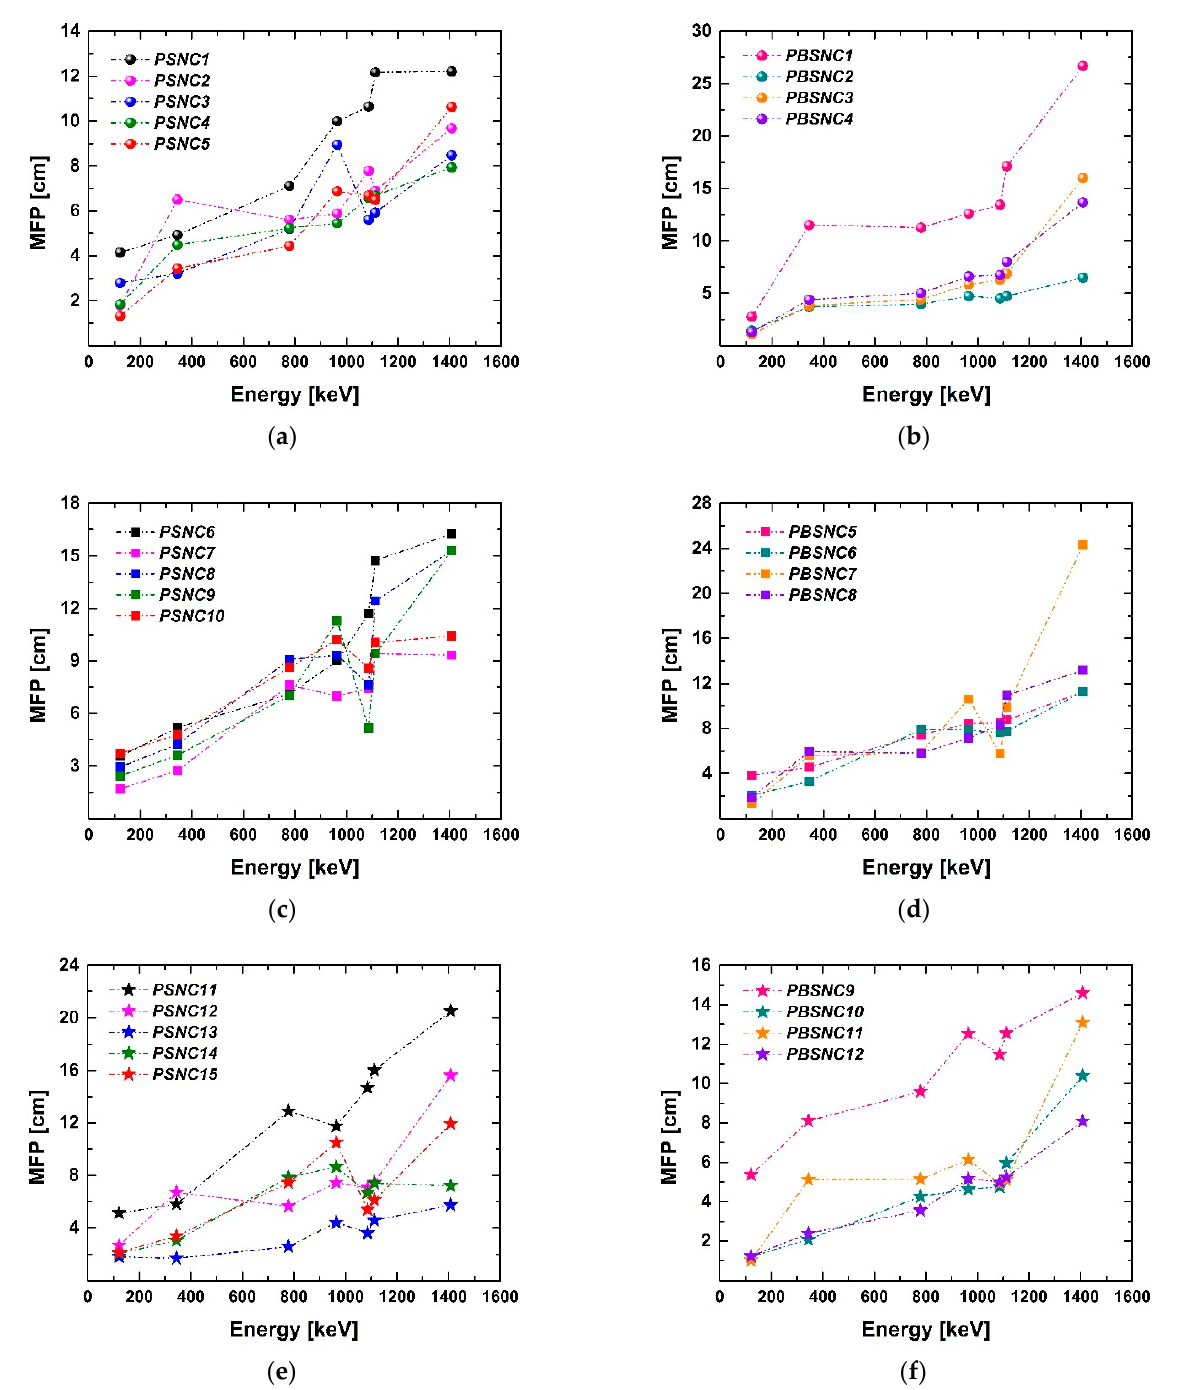
Figure 11. The MFP rates of the PS-b-PEG copolymers blended with the nanostructured SeO 2 and BN particles under a wide range of gamma irradiation energies: PSNC1, PSNC2, PSNC3, PSNC4, and PSNC5 ( a ); PBSNC1, PBSNC2, PBSNC3, and PBSNC4 ( b ); PSNC6, PSNC7, PSNC8, PSNC9, and PSNC10 ( c ); PBSNC5, PBSNC6, PBSNC7, and PBSNC8 ( d ); PSNC11, PSNC12, PSNC13, PSNC14, and PSNC15 ( e ); PBSNC9, PBSNC10, PBSNC11, and PBSNC12 ( f ). Furthermore, by computing the RPE rates, the ability of our polymer-based nano-